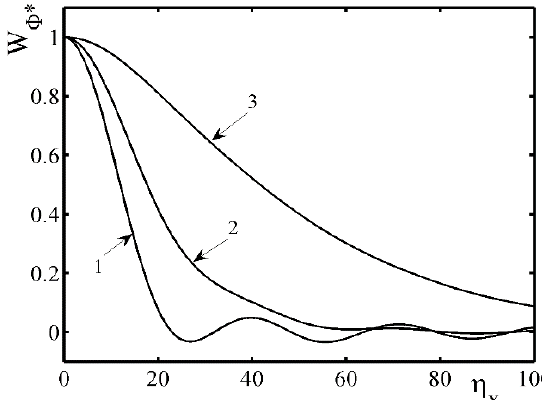
Figure 1: The same as in Figure 1 for spectral function (13).